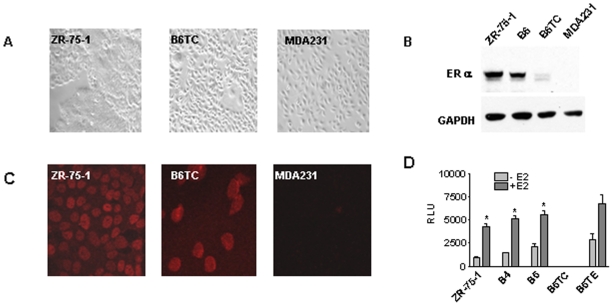
Characterization of estrogen-independent B6TC cells.(A) Morphology of ZR-75-1, B6TC and MDA-MB-231 cells as detected under bright field. (B) Western blot analysis in the cell extracts of the parental ZR-75-1, B6, B6TC and MDA-MB-231 control cells with antibodies to ER-α. GAPDH levels were measured in cell lysates to show equal sample loading. (C) Representative immunocytochemical staining pictures for the expression of ERα in ZR-75-1, B6TC and MDA-MB-231 cells were taken in confocal microscope under 60X magnification. (D) To confirm the expression of a functional ERα, the cells were transiently cotransfected with an estrogen-responsive promoter-luciferase report plasmid (ERE-thymidine kinase-Luciferase) and a β-gal expression plasmid. Cells were treated with 10-7 M E2. Luciferase and β-gal activities in cell lysates were determined. Luciferase activity normalized with β-gal activity is presented as the mean±SEM for each treatment from triplicate transfections. The asterisk “*” indicates significant difference between the –E2 and +E2 groups with Student t tests at P<0.05.